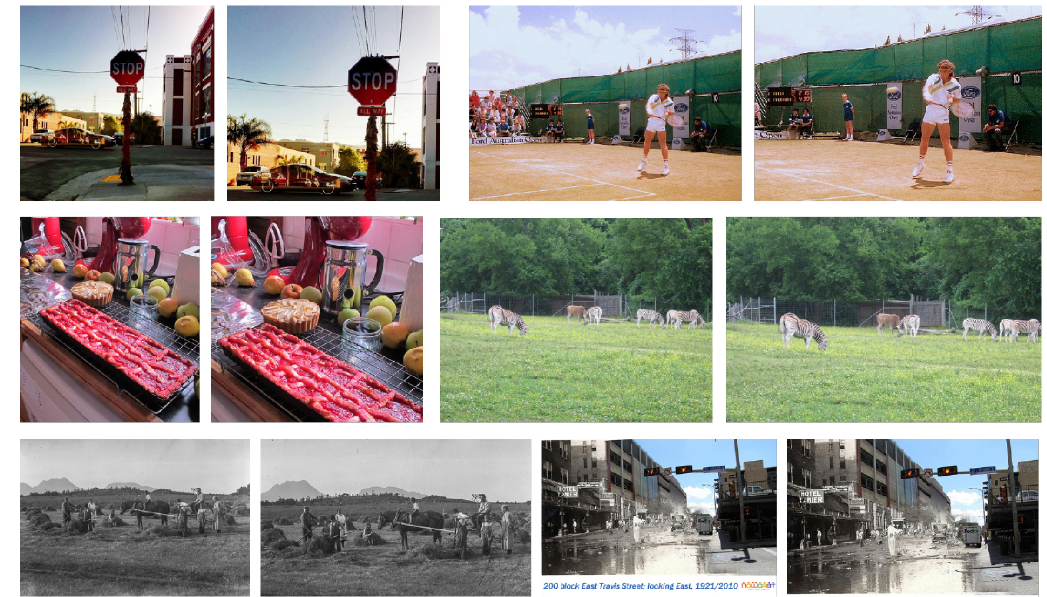
Fig. 12 Cropping results from SAC-Net without subject mask input. In each pair, the input image is on the left and the cropped result on the